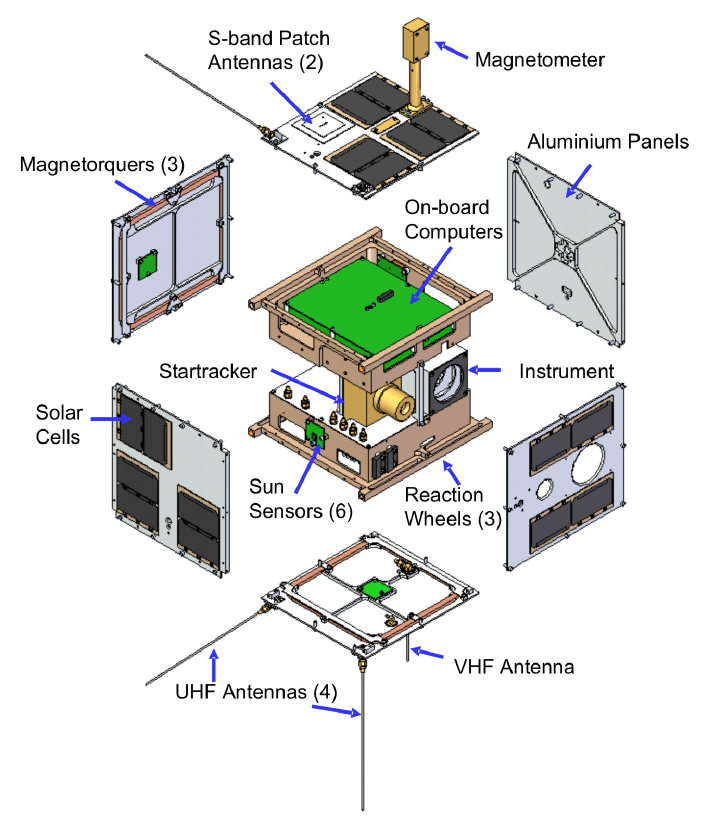
Figure 3. Basic structure of the BRITE satellites. Source: